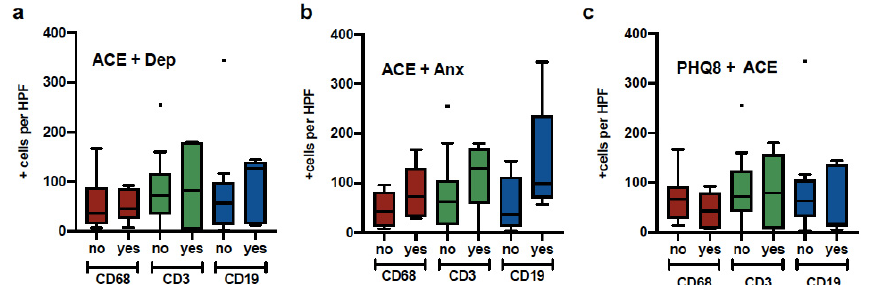
Figure 2. Macrophage, T cell and B cell expression in patients with psychological distress . Tumor samples from breast cancer patients were quantified for Macrophage (CD68), B cells (CD19) and T cells (CD3) and divided into groups a) Elevated ACE and history of depression, b) Elevated ACE and GAD7, c) Elevated PHQ8 and Elevated ACE.